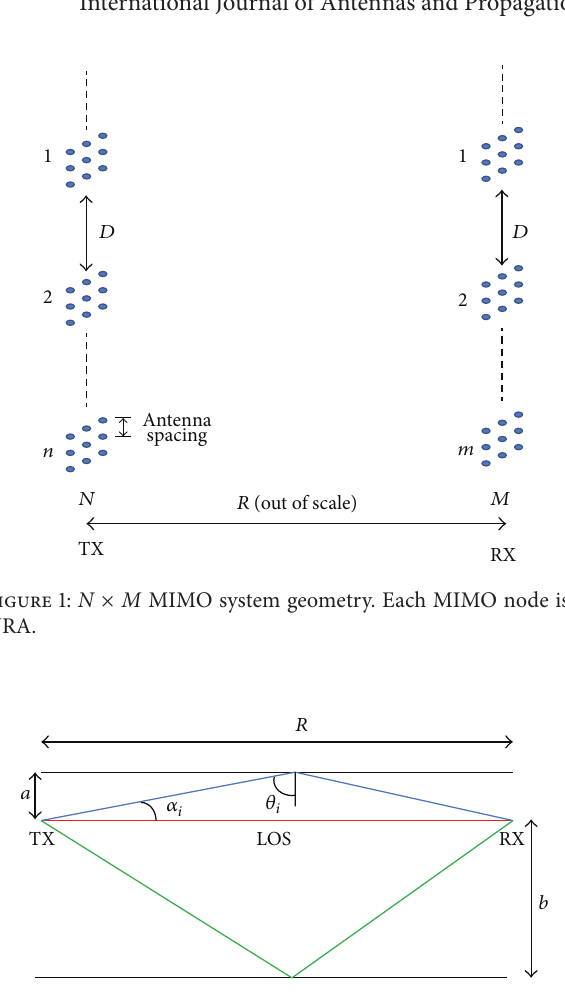
Figure 2: Environment (aerial view). The LOS line is normal to the URA